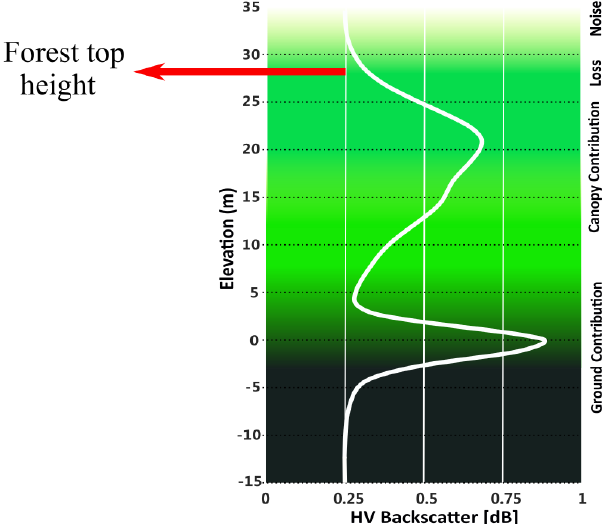
Figure 3. Schematic view of the vertical backscatter distribution (TomoSAR Capon profile at a certain cell). H: horizontal; V: